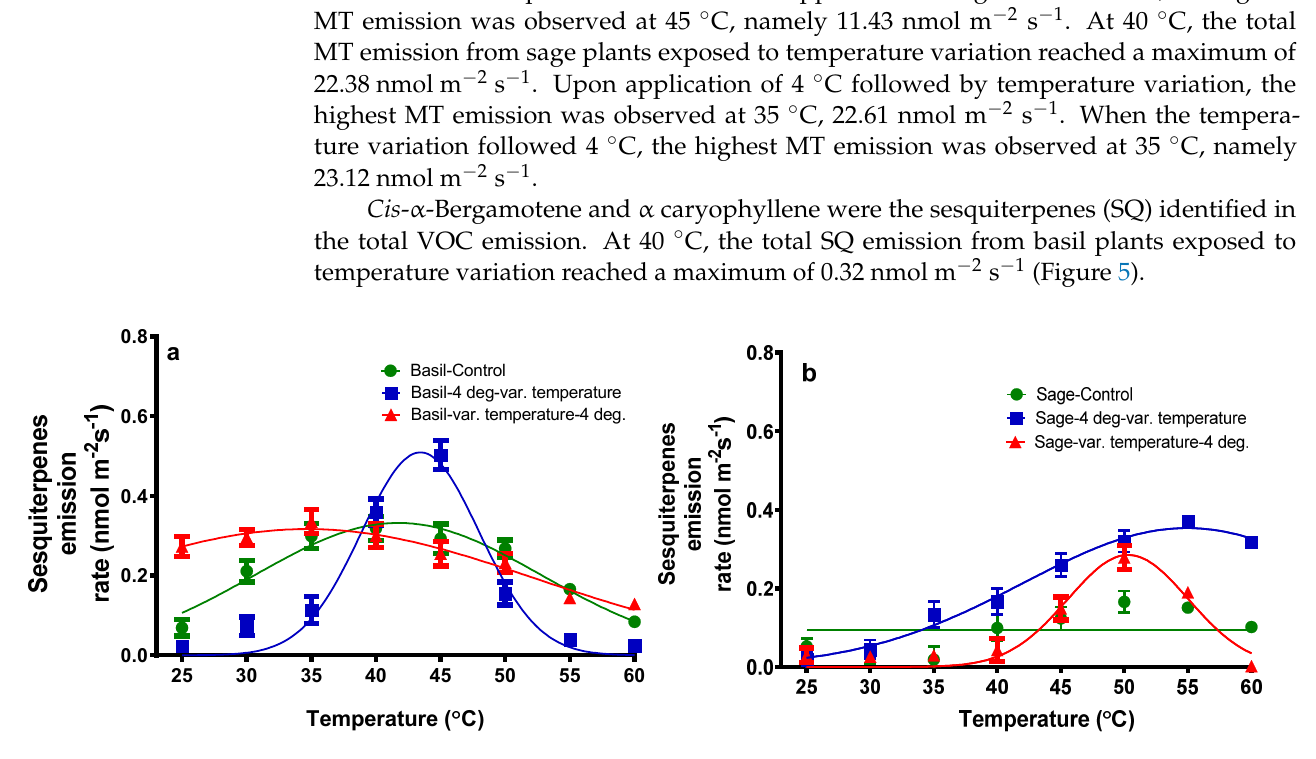
Figure 5. The sesquiterpenes emission rate from basil plants ( a ) and sage plants ( b ); plants were subjected to different temperatures.